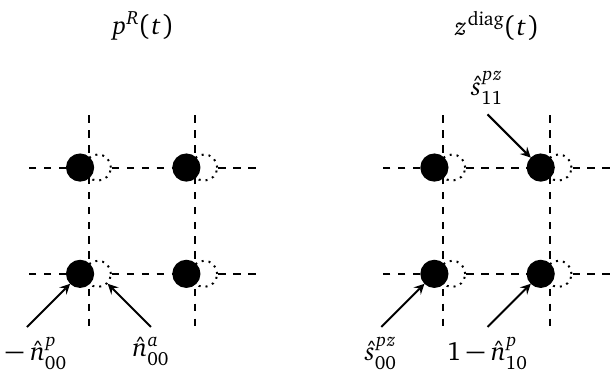
Figure 1: Top view of a single iPEPS unit cell, representing a state | ψ ( t ) 〉 . Each site is the product space of a physical (black) and auxiliary (white / dotted) site. Sites are connected via iPEPS virtual bonds (dashed). Left: The return probability p R ( t ) is evaluated by measuring 1 − ˆ n p and ˆ n a at the same iPEPS site. Right: The equal-time i i correlator z diag ( t ) around a hole at time t is evaluated by measuring ˆ s pz 1 − ˆ n p 10